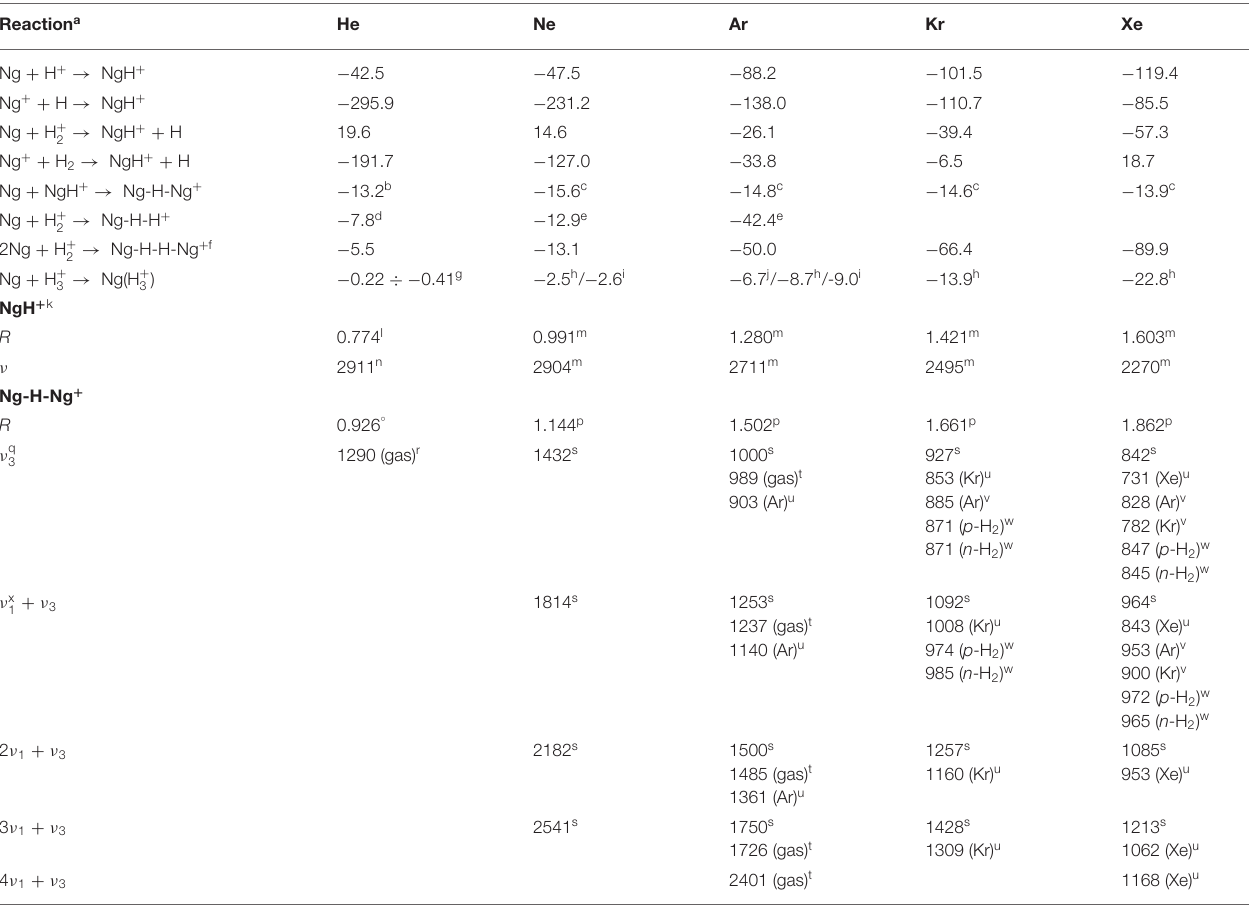
TABLE 1 | Energetics (kcal mol − 1 ) of reactions involving the gaseous Ng m H n + , and bond distances ( R , Å) and vibrational frequencies ( ν , cm − 1 ) of the NgH + and Ng-H-Ng + . Reaction